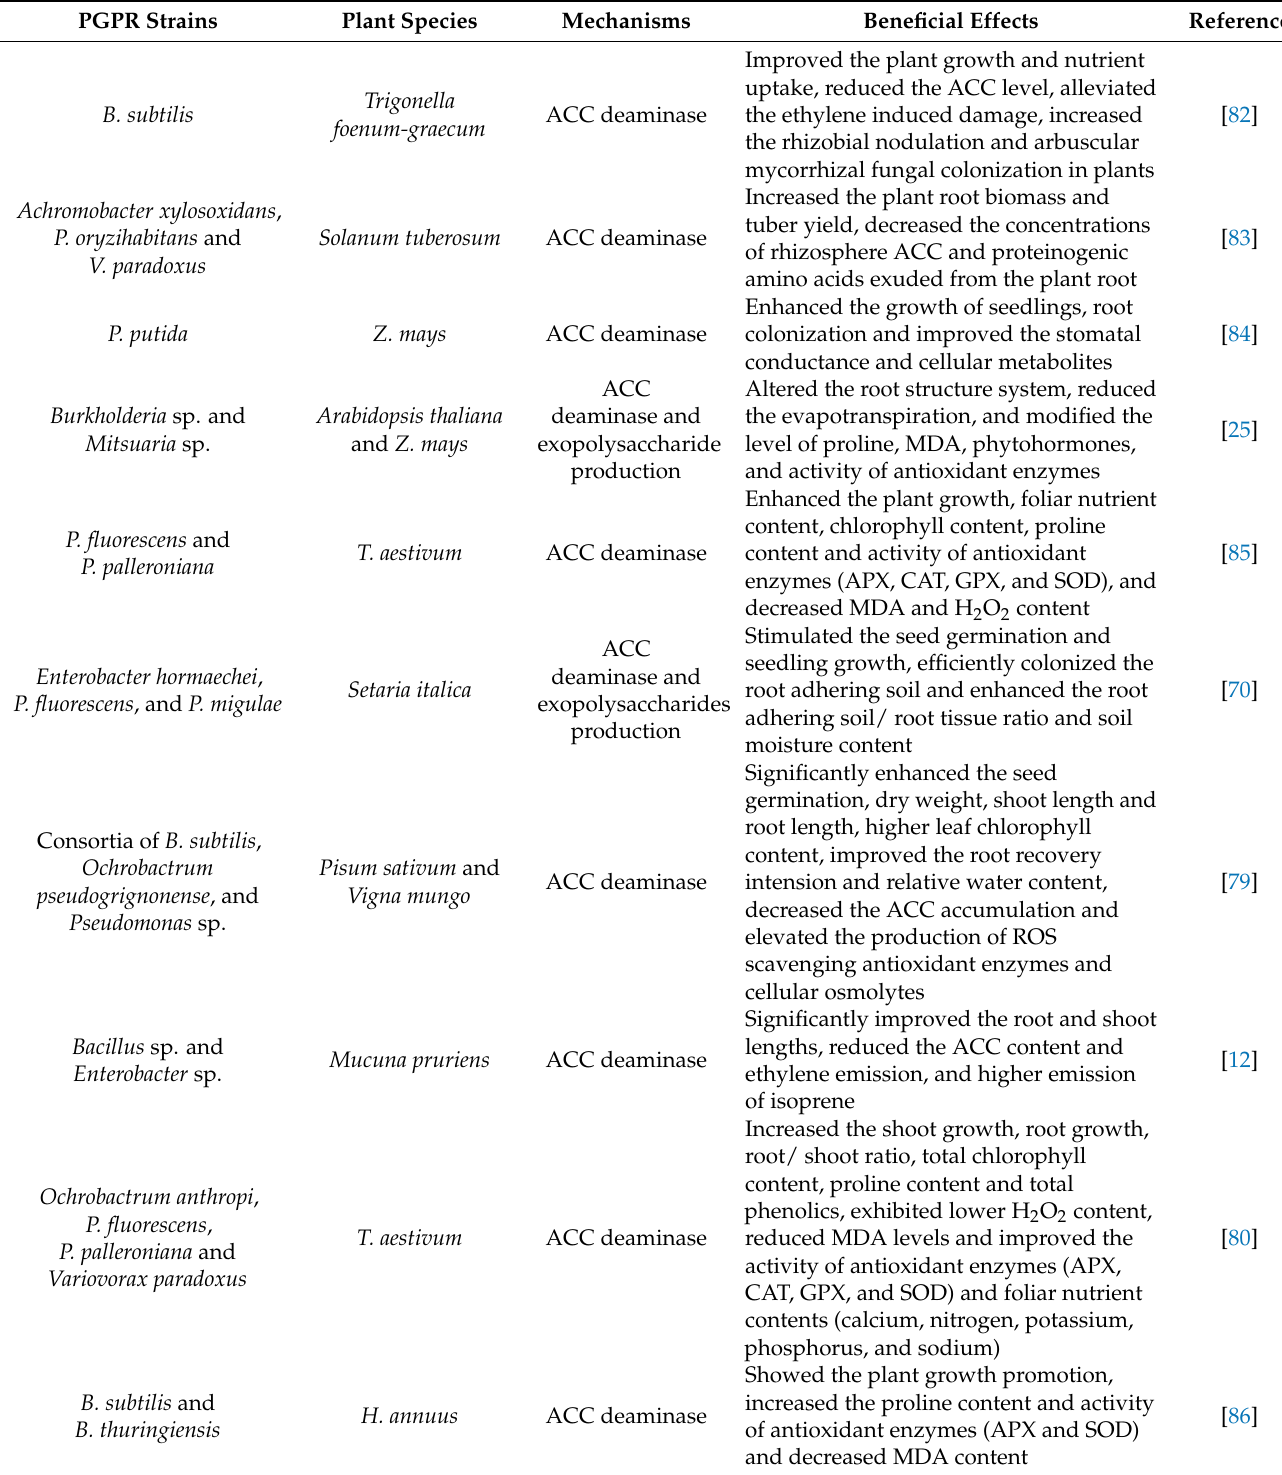
Table 2. ACC deaminase and exopolysaccharide producing PGPR in the alleviation of plant drought